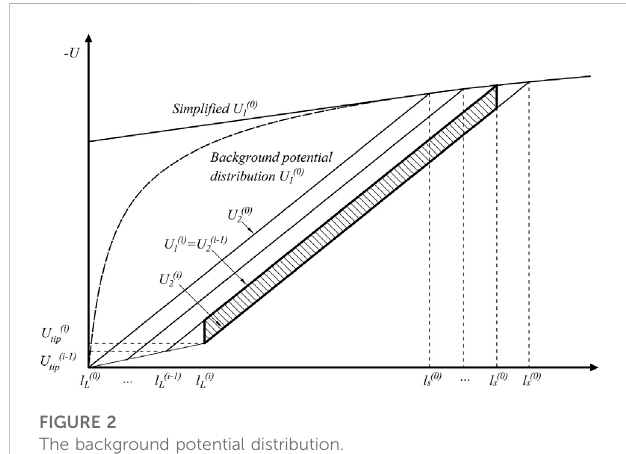
FIGURE 2 The background potential